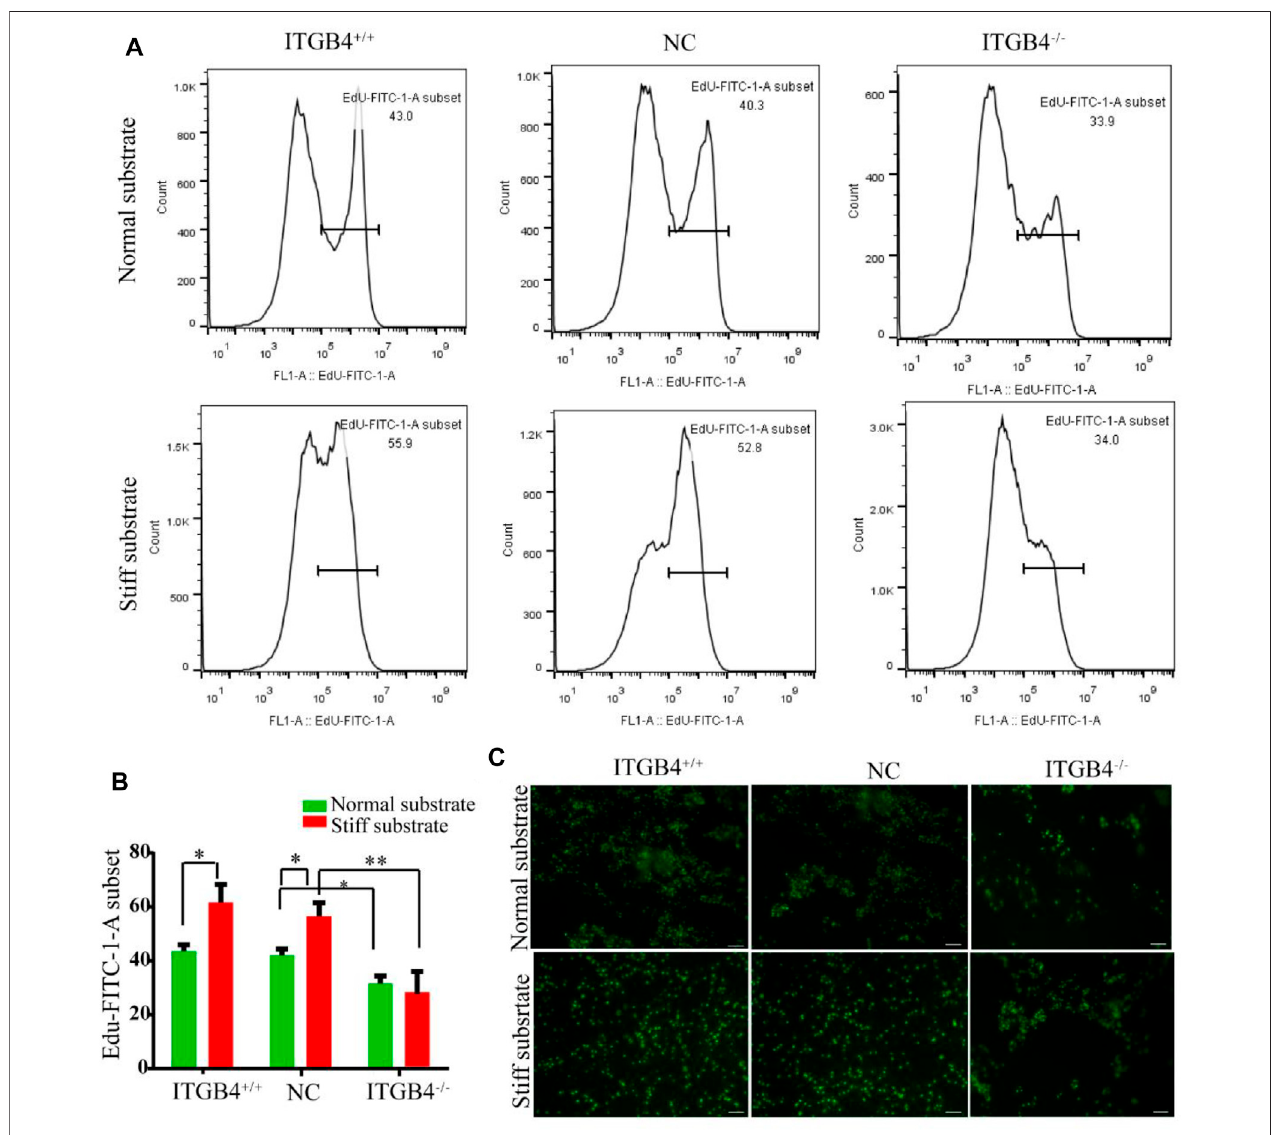
FIGURE 7 | Proliferation of cells on the normal and stiff substrates. (A) Proliferation of cells was determined by fl ow cytometry. (B) Flow cytometry results were quanti fi ed. (C) The proliferation of cells was detected by using the EdU kit. ( n = 3 independent experiments, * p < 0.05; ** p < 0.01). Data are presented as mean ± SD.